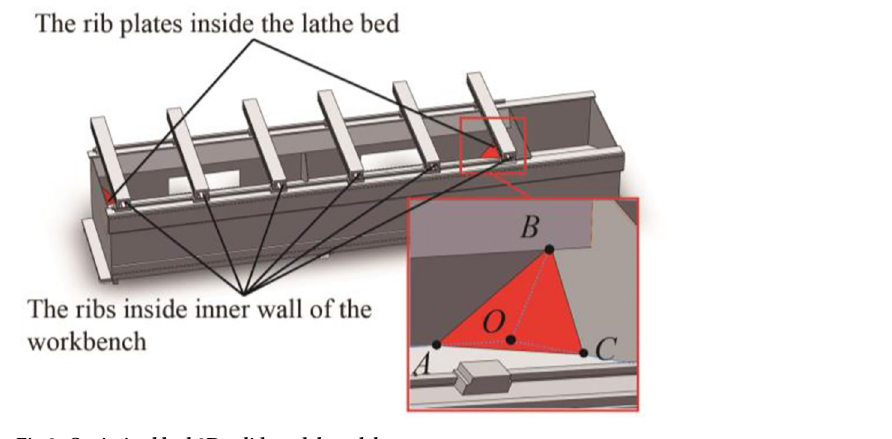
Fig 9. Optimized bed 3D solid model